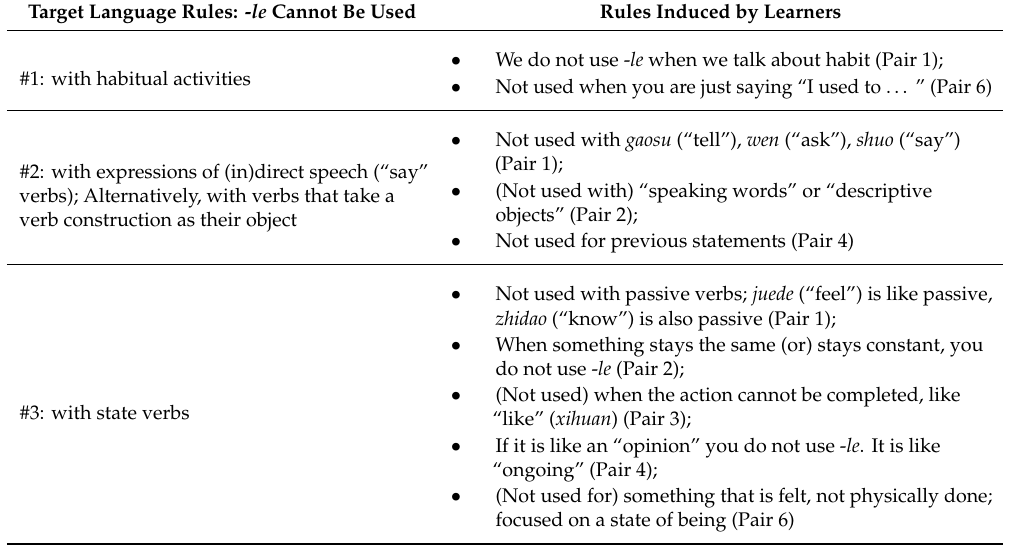
Table 6. Rules induced by participants, corresponding to target language rules 5